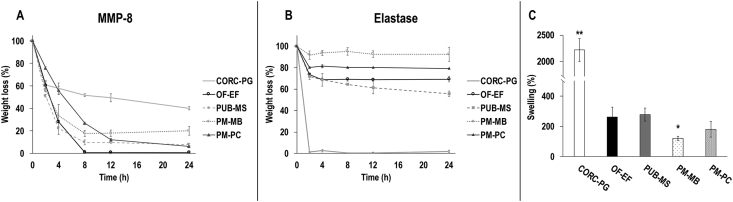
The CORC-PG showed the highest resistance to collagenase digestion (A) and the lowest resistance to elastase digestion (B). Among the tissue grafts, the PM-MB showed the highest resistance to collagenase (A) and elastase (B) digestion. The CORC-PG exhibited the highest PM-MB and the lowest swelling capacity (C). Data expressed as average ± standard deviation (n = 3). ∗∗Indicates statistically higher (p<0.01) groups and ∗Indicates statistically lower (p<0.05) groups.